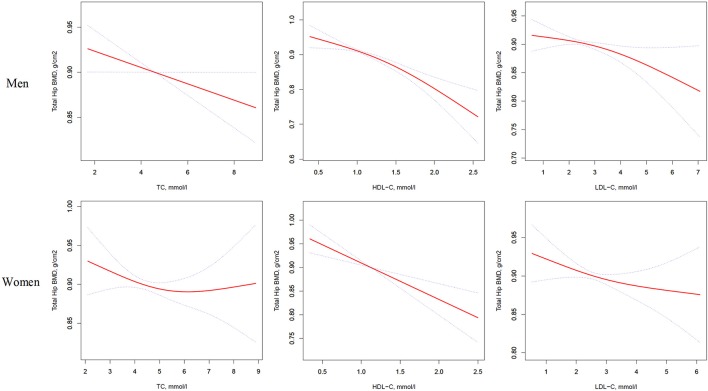
Multivariate adjusted smoothing spline plots of total hip BMD by TC, HDL-C, and LDL-C. Red dotted lines represent the spline plots of TC, HDL-C, and LDL-C and blue dotted lines represent the 95% CIs of the spline plots. Adjusted for age; diabetic duration(y); treatment of DM; smoking; drinking; BMI; cerebrovascular disease; kidney disease; family history of DM; diastolic blood pressure; FBG, unit; Cr, umol/l; BUN, mmol/l; Ca, unit; ALT, U/L; AST, U/L; ALP, U/L.